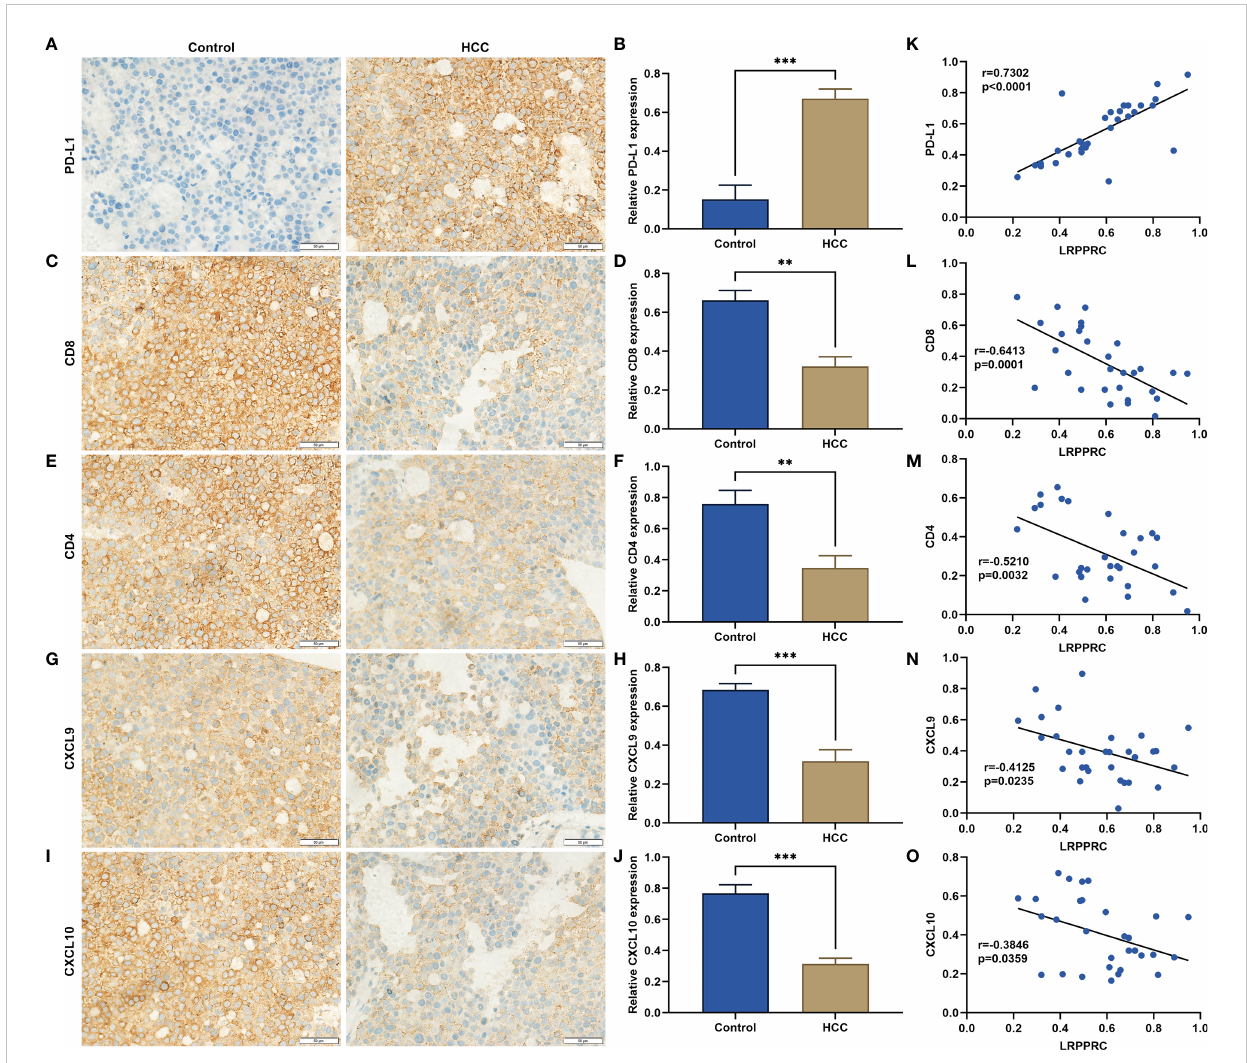
FIGURE 4 Leucine rich pentatricopeptide repeat containing (LRPPRC) exhibits a negative correlation to anti-tumor immunity and immune in fi ltration in hepatocellular carcinoma (HCC). (A – J) Representative immunohistochemical staining photographs and quanti fi cation results of (A, B) PD-L1, (C, D) CD8, (E, F) CD4, (G, H) CXCL9, (I, J) CXCL10 in 30 paired HCC, and normal tissues. (K – O) Scatter plots illustrating the relationships of LRPPRC with (K) PD-L1, (L) CD8, (M) CD4, (N) CXCL9, and (O) CXCL10. ** p < 0.01; *** p <